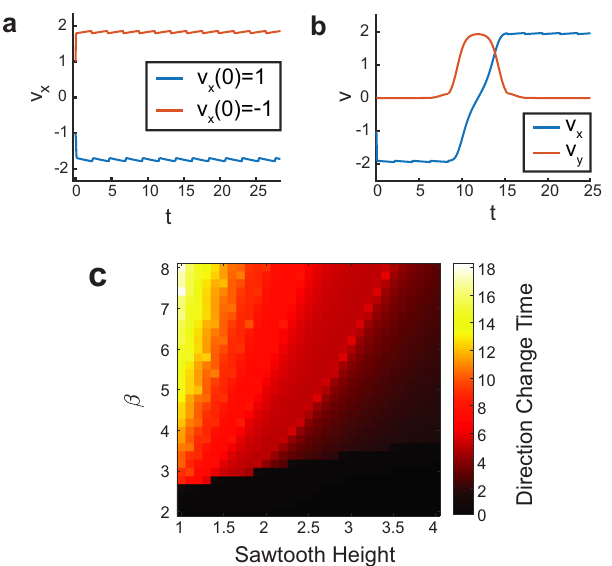
Fig. 6 Toy model capturing the main features of the full 3D phase- fi eld model. a Trajectories up and down the sawteeth in the simpli fi ed model, Eq. (2), in the 1D case. b A cell that initially moves up sawteeth in the 2D model, Eq. (2) performs a U-turn at t ≈ 10. The initial trajectory is unstable. c Heat map of the time for cells with initial negative velocity to change direction in the 2D model. For higher values of β in this model, the velocity up the sawteeth persists for a longer time. For higher values of c (height of sawtooth pattern) in this model, the velocity up the sawteeth persists for a shorter